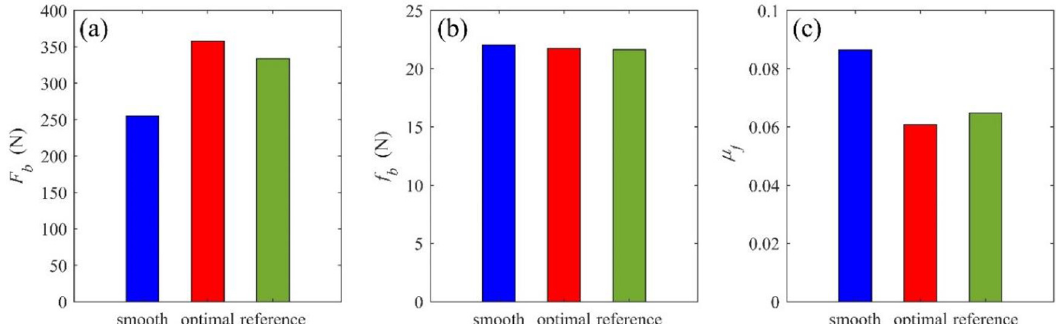
Fig. 9. Comparisons of (a) load carrying capacity, (b) friction, (c) friction coef fi cient, between smooth, optimal textured, and reference textured bearings under e = 0.1, ’ =